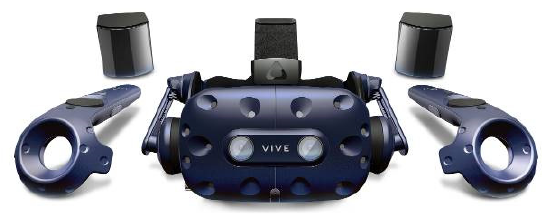
Figure 2. HTC Vive Pro setup including two controller and lighthouse tracking system (www.vive.com)